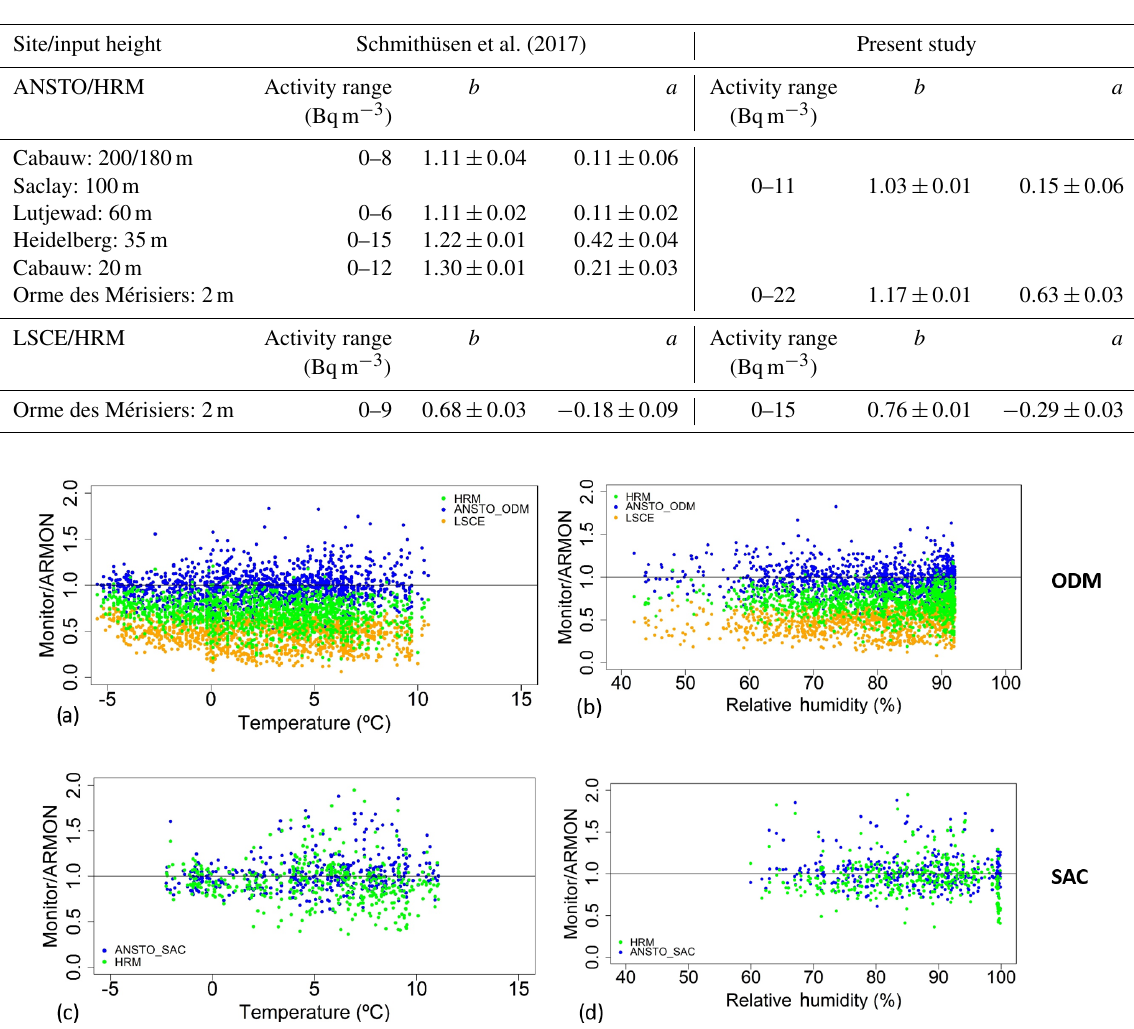
Table 3. Offsets and slopes of the regression lines calculated between ANSTO or LSCE monitors against the HRM in the present study and by Schmithüsen et al. (2017).